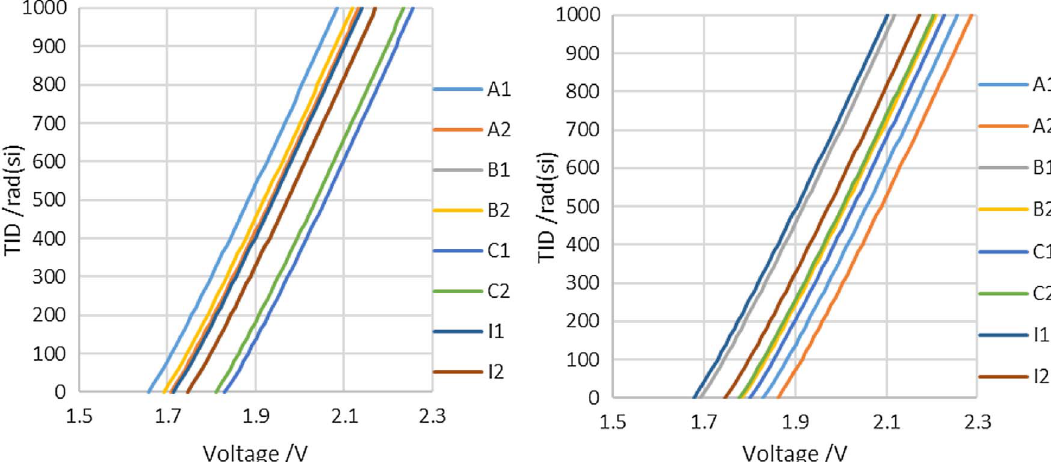
Fig. 12. RadFET voltage vs. total received dose for RadMon fl ight models FM1 and